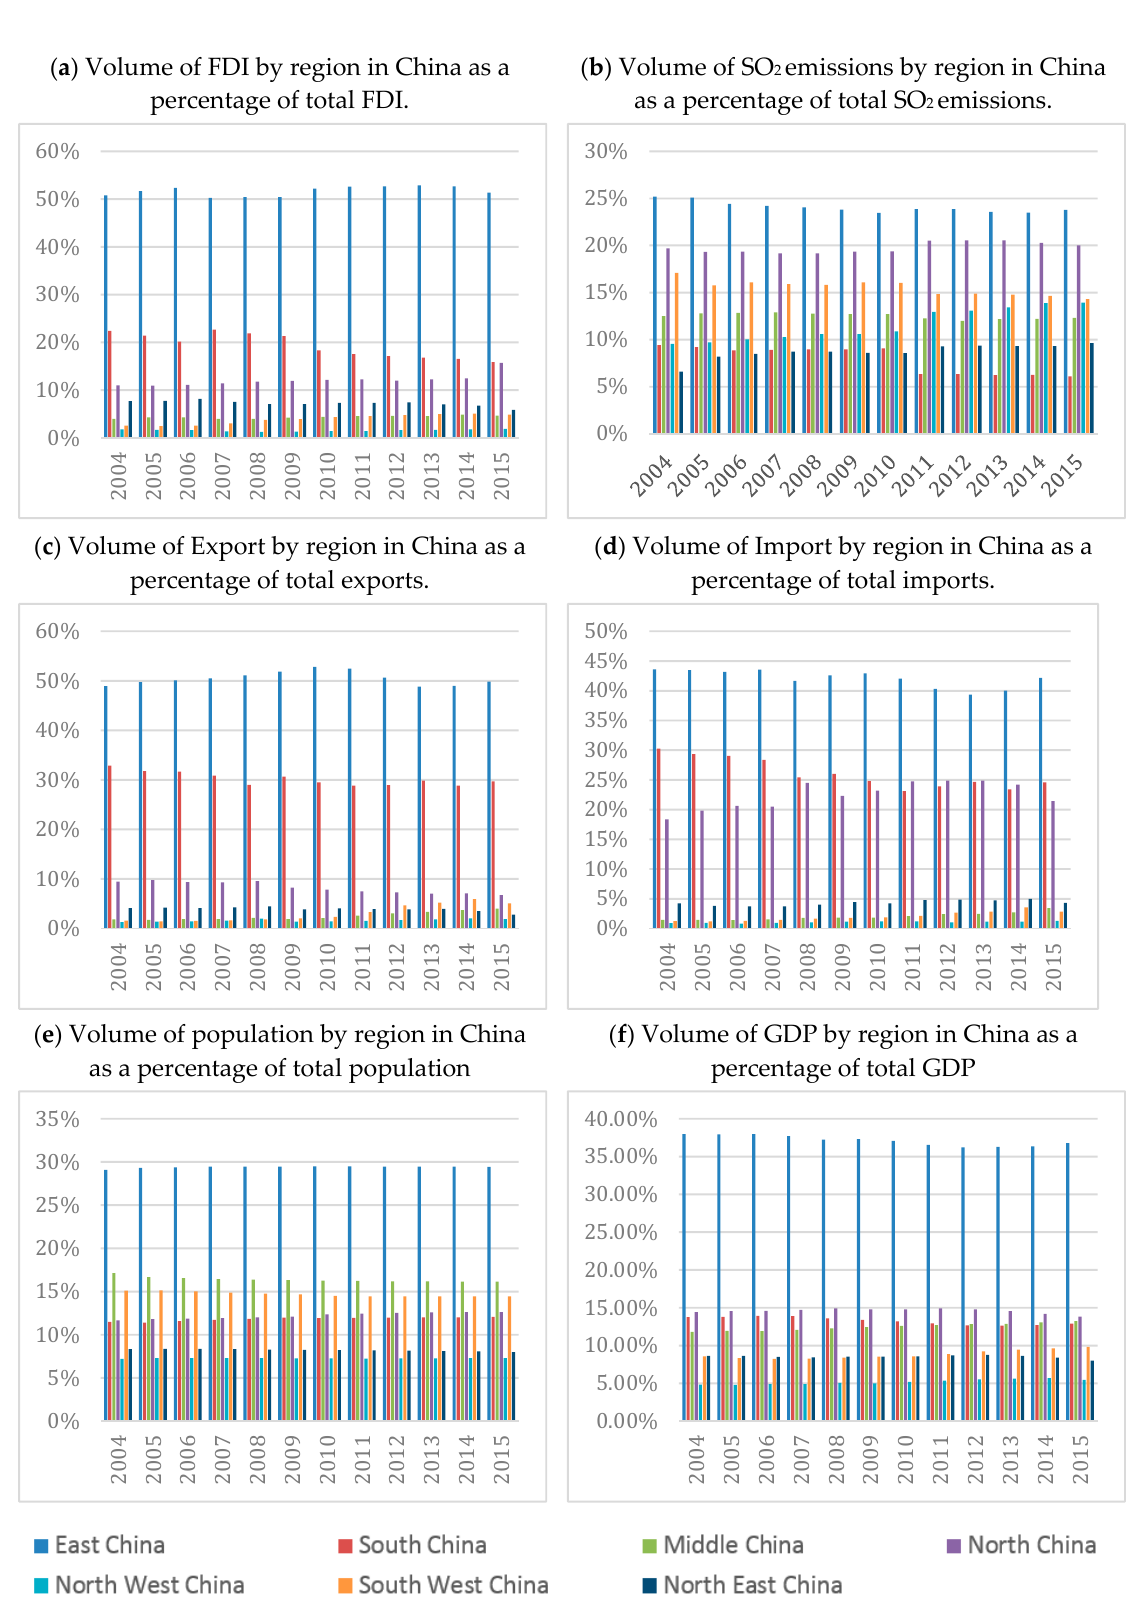
Figure 2. Economic and environment performance in China by sector and by region.